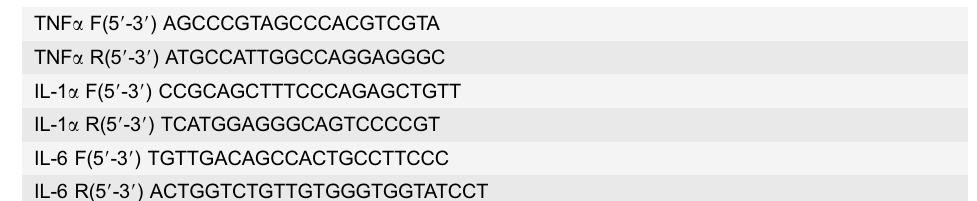
Table 1. Primers used in real-time